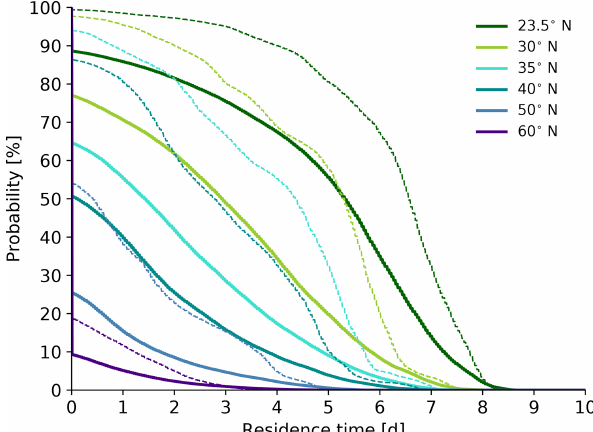
Figure 2. Exceedance probabilities of the residence time in different spherical caps (north of 23.5, 30, 35, 40, 50 and 60 ◦ N) of air parcels arriving in the sub-cloud layer ( p ≥ 940hPa) in Barbados, based on a climatology of 10d back trajectories from Barbados calculated with ERA5 in January and February 2009 to 2018 (568320 trajec- tories, solid lines) and for January and February 2018 (isoTrades campaign; 23040 trajectories, dashed